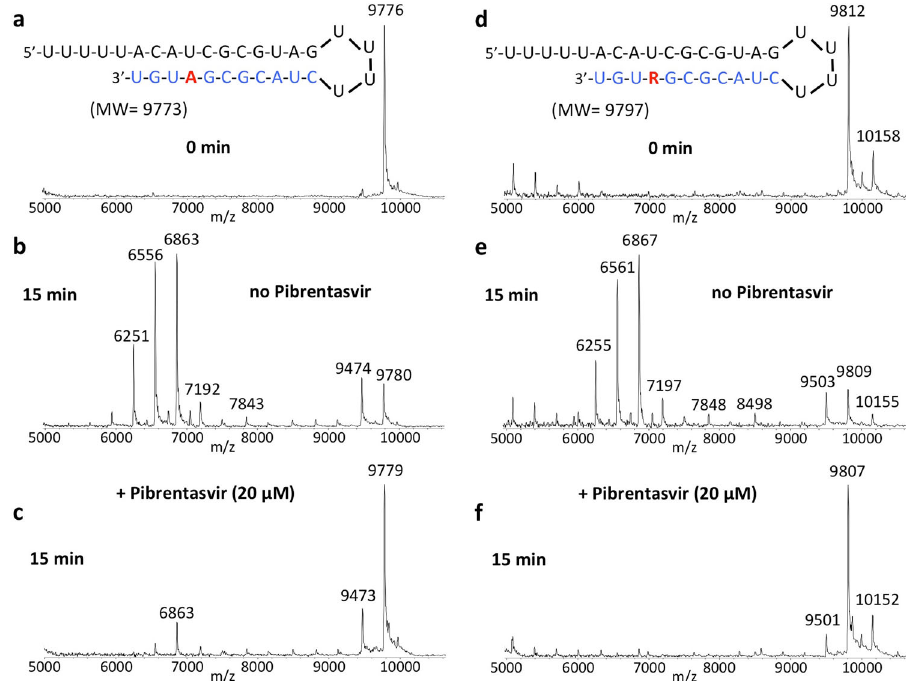
Fig. 5 Inhibition of SARS-CoV-2 exonuclease activity by Pibrentasvir for natural RNA and RNA with delayed termination by Remdesivir (R). A mixture of 400 nM RNAs (sequences shown at the top of the fi gure) and 50 nM SARS-CoV-2 pre-assembled exonuclease complex (nsp14/nsp10) were incubated in buffer solution at 37 °C for 15 min in the absence ( b , e ) and presence of 20 µ M Pibrentasvir ( c , f ). The intact RNAs ( a , d ) and the products of the exonuclease reactions ( b , c , e , f ) were analyzed by MALDI-TOF MS. The signal intensity was normalized to the highest peak. The peak at 9776 Da corresponds to the intact RNA (9773 Da expected) and the peak at 9812 Da corresponds to the intact Remdesivir delayed RNA termination product (9797 Da expected). The small peak at 10158 Da corresponds to mismatched incorporation of an additional G; this is likely due to the low fi delity of SARS- CoV-2 RdRp 11 . In the absence of Pibrentasvir, exonuclease activity caused nucleotide cleavage from the 3 ′ -end of the RNA as shown by the lower molecular weight fragments corresponding to cleavage of 1 – 11 nucleotides ( b , e ). When 20 µ M Pibrentasvir was added, exonuclease activity was reduced as shown by the reduced intensities of the fragmentation peaks and increased intact RNA peaks ( c , f